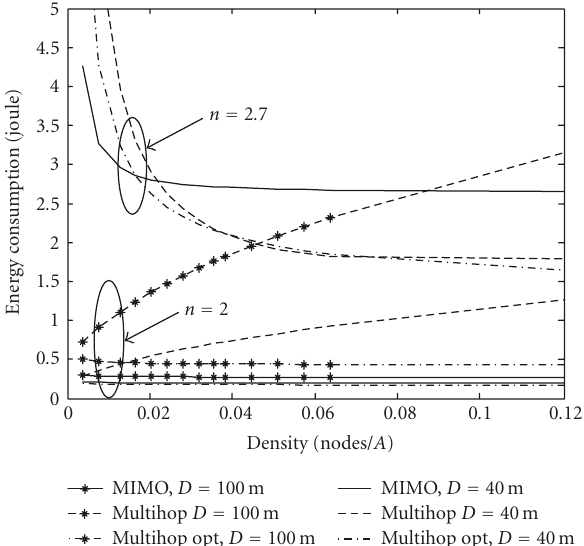
Figure 8: Energy gains inserted for D = 40m and di ff erent network